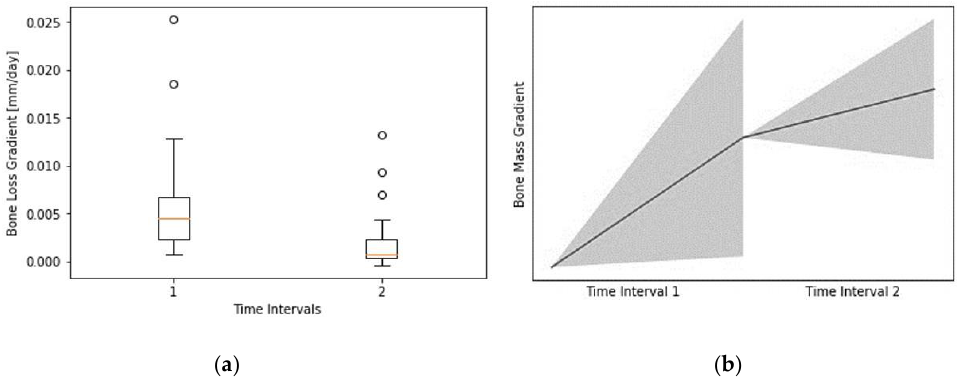
Figure 4. ( a ) Bone loss gradient in mm/day from surgery to loading (T0-T1; Time Interval (1) and loading to examination (T1-T2; Time Interval (2); ( b ) visualization of the box plot without any possible axis labeling based on the calculation of the gradients due to heterogeneous follow-up intervals. Created with SciPy (SciPy developers).